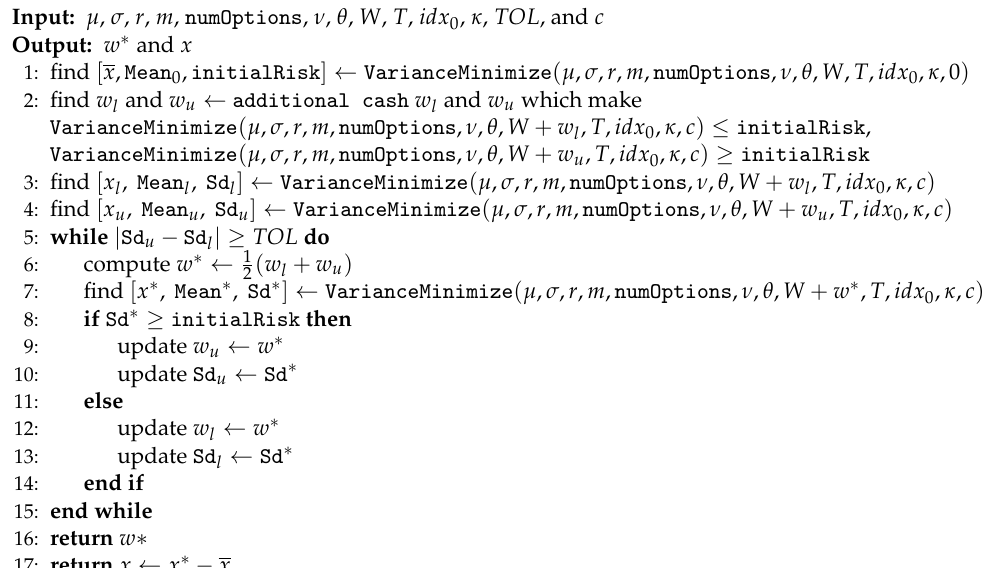
Algorithm 3: Indifference prices and hedging portfolios ( IndifferencePrices